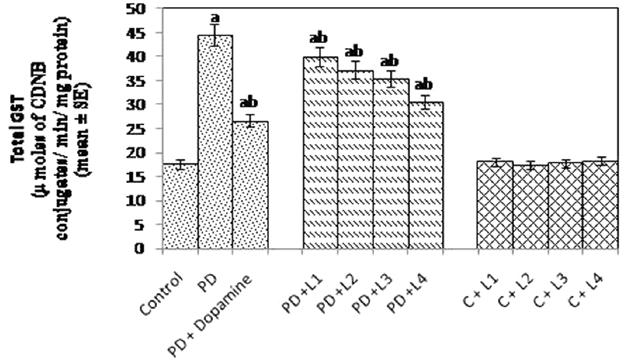
FIGURE 3 - Effect of luteolin on the glutathione- S -transferase (GST) activity in the brains of flies. [L1= 25 µM; L2= 50 µM; L3 = 75 µM; L4= 100 µM; PD = PD flies; Dopamine=10-3 M]. The flies were allowed to feed on the diet supplemented with luteolin for 24 days and then assayed for GST activity. The values are the mean of 5 assays. [a - significant at p<0.05 compared to control; b - significant at p<0.05 compared to PD flies].